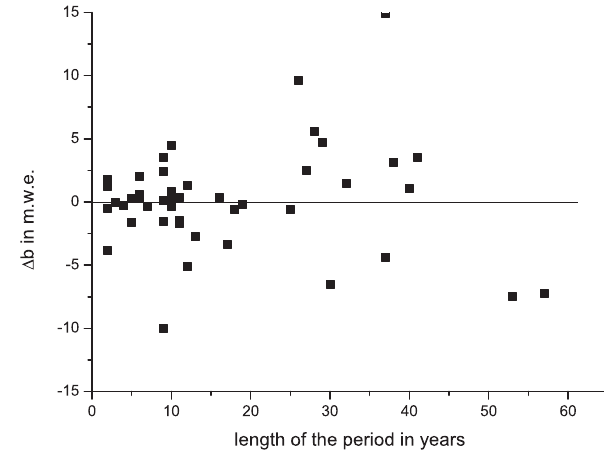
Fig. 17. Length of the period for which the geodetic mass balance b geo is calculated vs. the difference 1b between the geodetic and the direct mass balance.